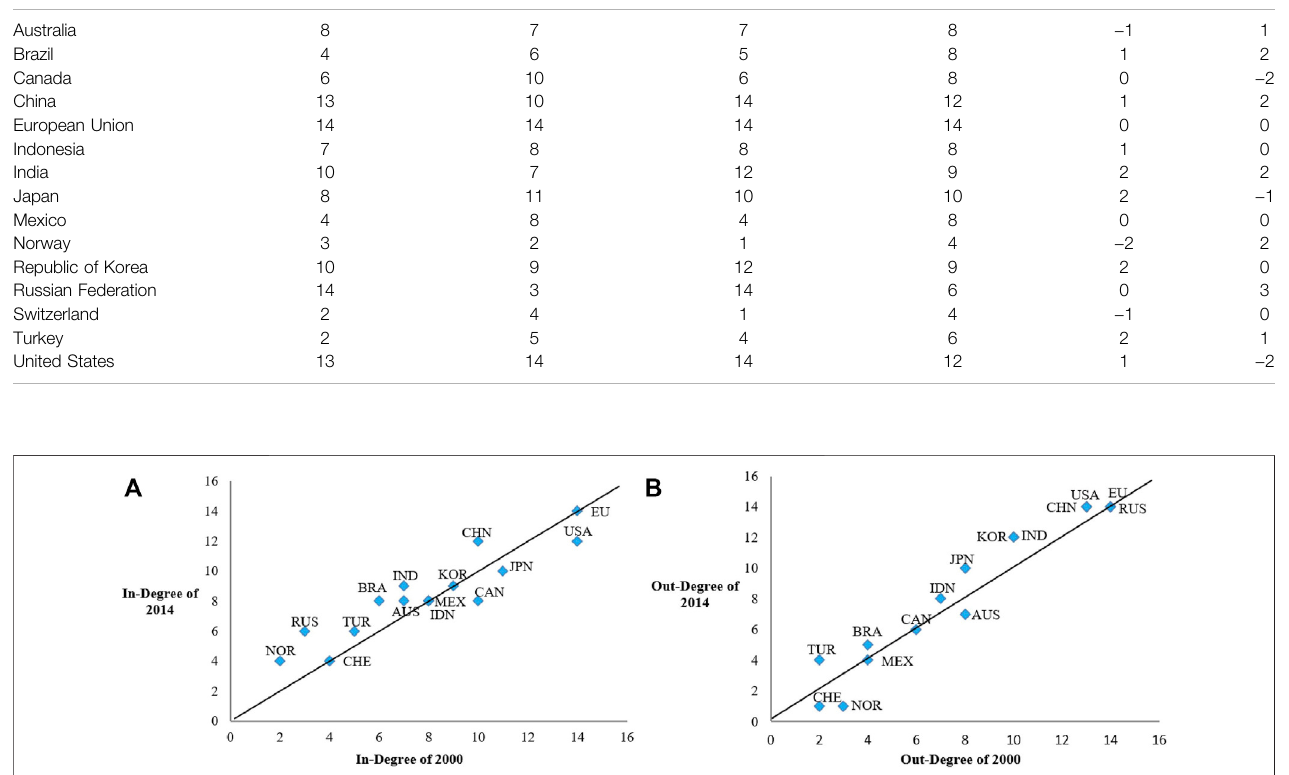
FIGURE 1 | Change of In-Degree and Out-Degree of main economies. (A) In-Degree of main economies in 2000 and 2014. (B) Out-Degree of main economies in 2000 and